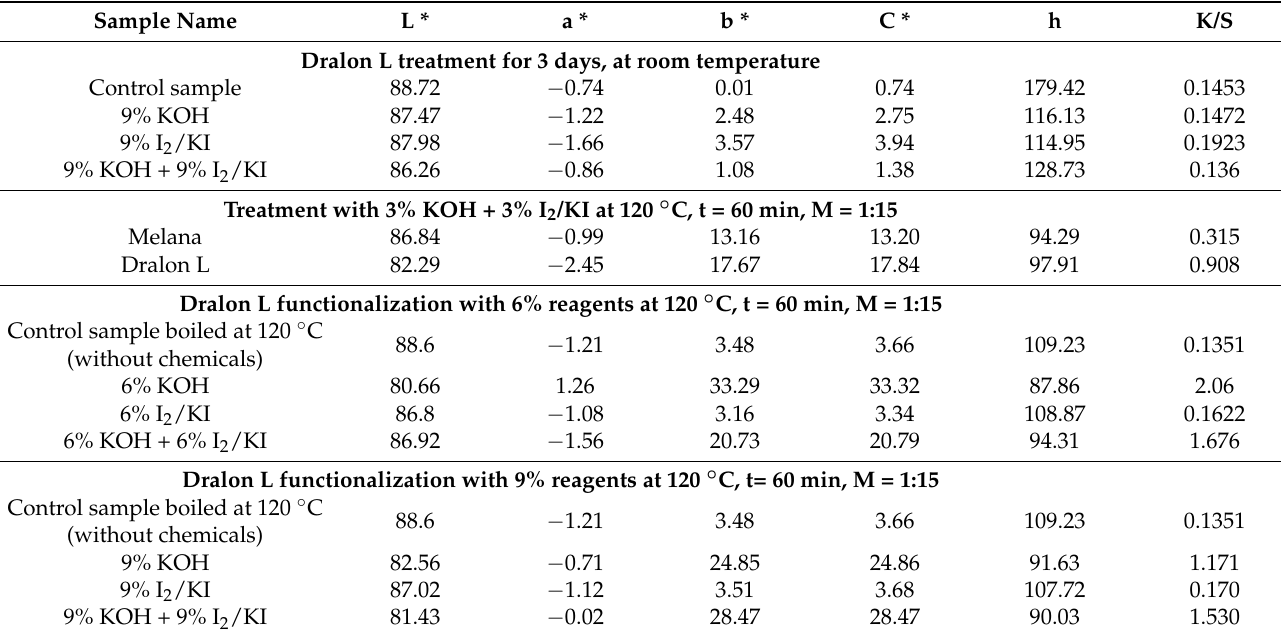
Table 6. CIELab values of acrylic fibers after controlled functionalization.